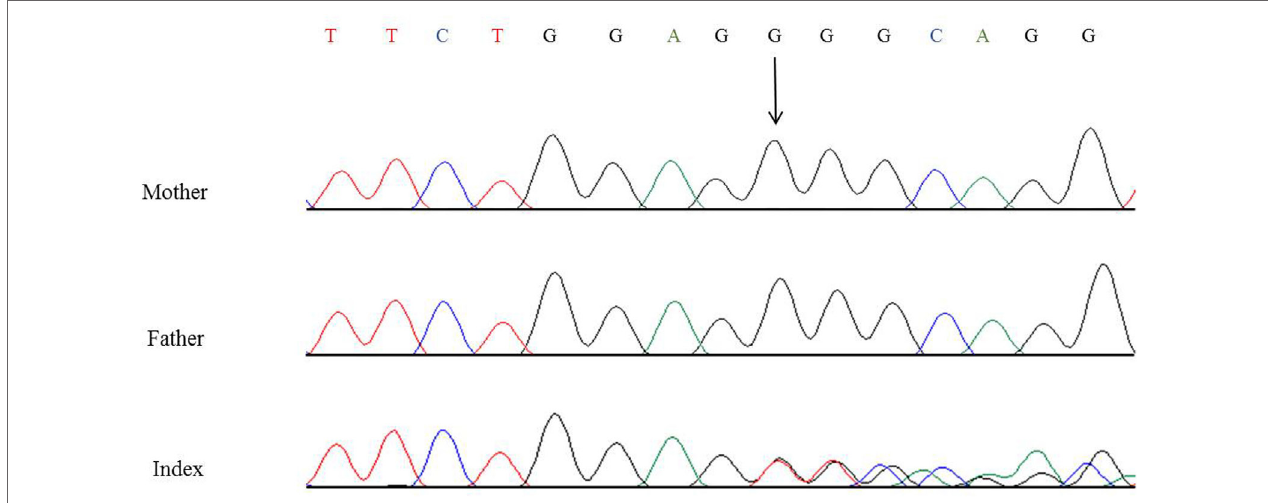
FIgURe 6 | Partial nucleotide sequence of exon 3 of PBX1 of the patient and his parents showing the heterozygous de novo variant c.413_419delGGGCAGG, p.Gly138Valfs*40. Shown reference sequence: TTCTGGAGGGGCAGG. Genomic position of the variant: chr1:164761876–164761882 (hg19, transcript NM_002585.3).